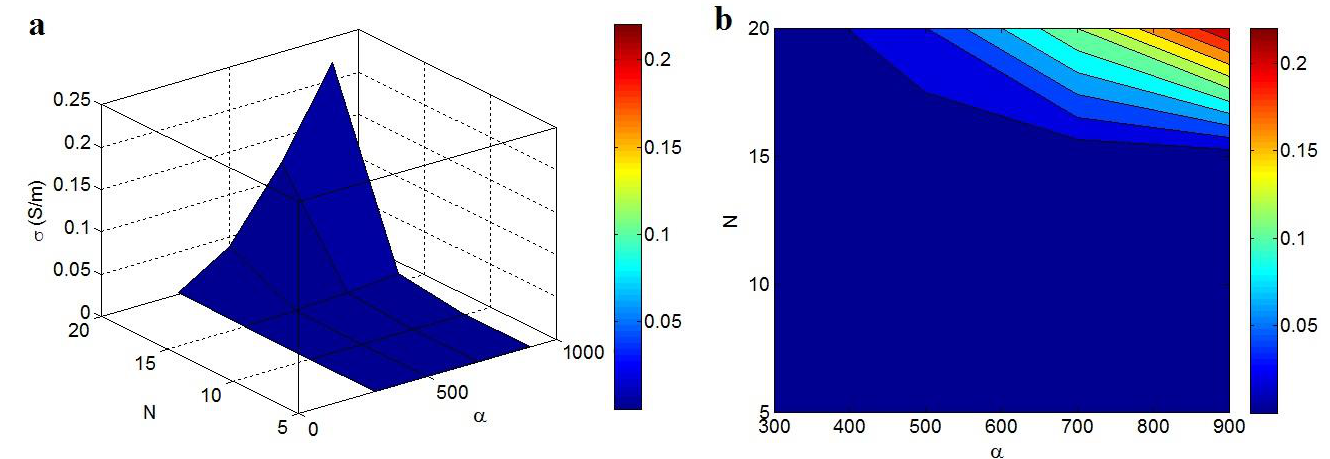
Figure 7. Impact of “α” and “N” on the conductivity by ( a ) 3D and ( b ) 2D schemes.